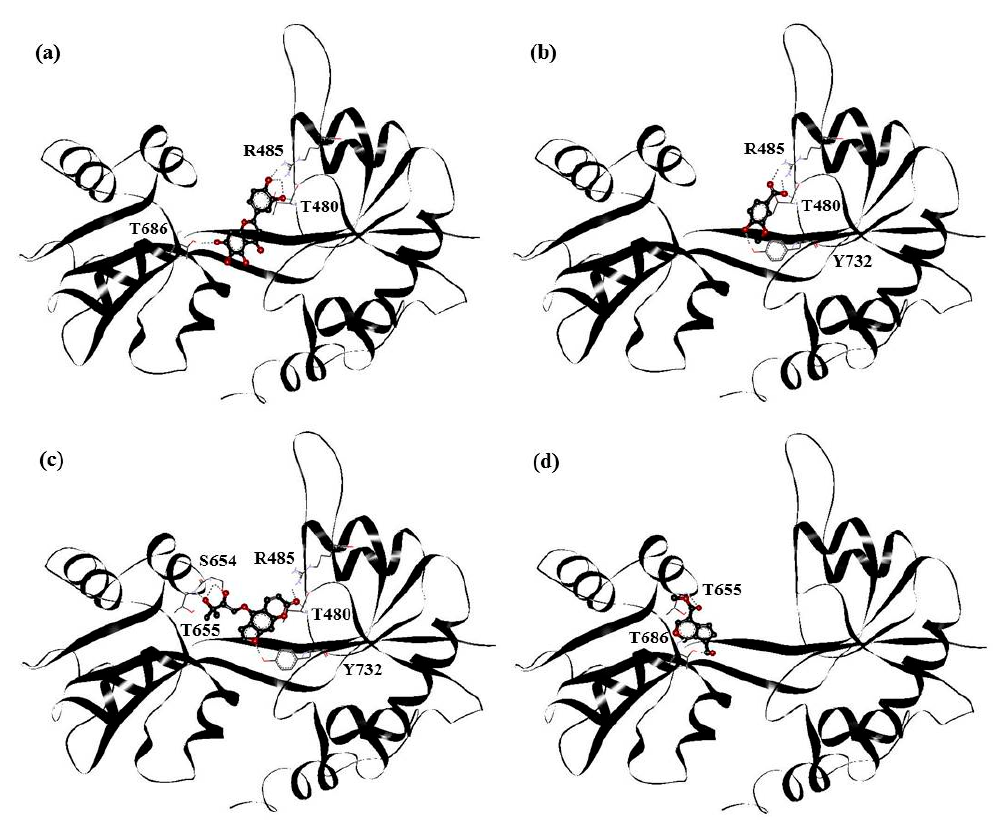
Figure 3. The docking result of ( a ) PHF; ( b ) HMB; ( c ) DHMBP; ( d ) cerbinal system. The red and black balls represent oxygen and carbon atoms. The black line represents backbone of GluR2.